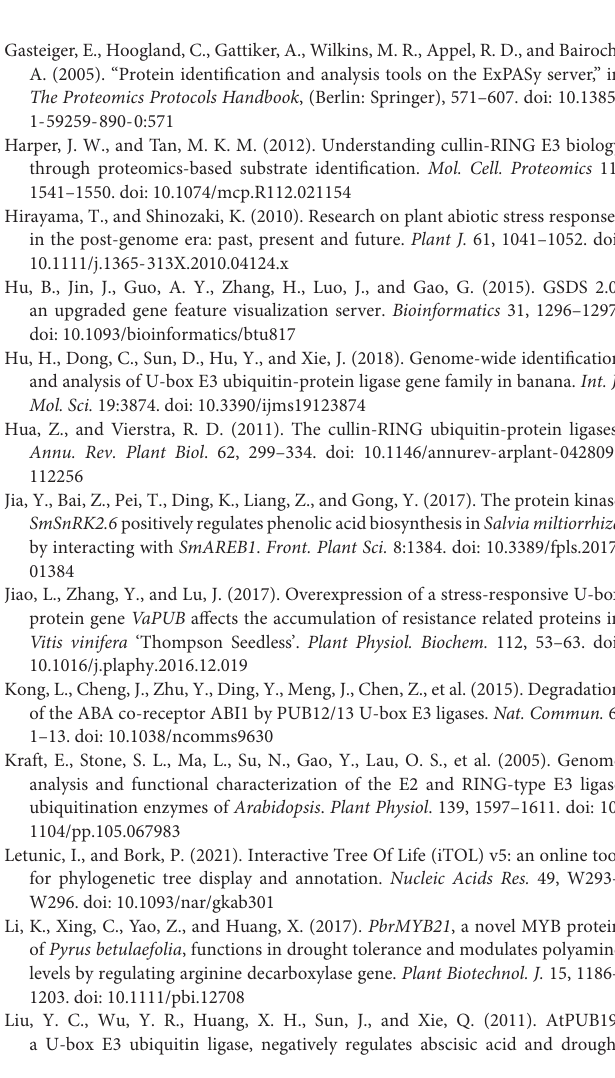
Supplementary Figure 1 | The location of UBE3 genes in S. miltiorrhiza genome. Supplementary Figure 2 | Ten motifs identified using MEME suit for U-box gene family. Supplementary Figure 3 | The number of 14 cis -acting elements in each putative promoter of UBE3 genes. The color scale at the bottom indicated the number of cis -acting elements. Supplementary Figure 4 | The word cloud image of cis -acting elements in the promoter of 60 UBE3 genes. Supplementary Figure 5 | Gene ontology analysis of 60 UBE3 genes in S. miltiorrhiza . (A) Gene ontology analysis of the identified UBE3 genes in S. miltiorrhiza . (B) The molecular function of UBE3 genes in S. miltiorrhiza . (C) The biological process of UBE3 genes in S. miltiorrhiza . (D) The cellular component of UBE3 genes in S. miltiorrhiza . Supplementary Figure 6 | Correlation of gene expression results obtained from qRT-PCR and RNA-seq. Supplementary Figure 7 | The co-expression network of UBE3 genes and phenolic acids biosynthetic genes. Supplementary Figure 8 | The co-expression network of UBE3 genes and tanshinone biosynthetic